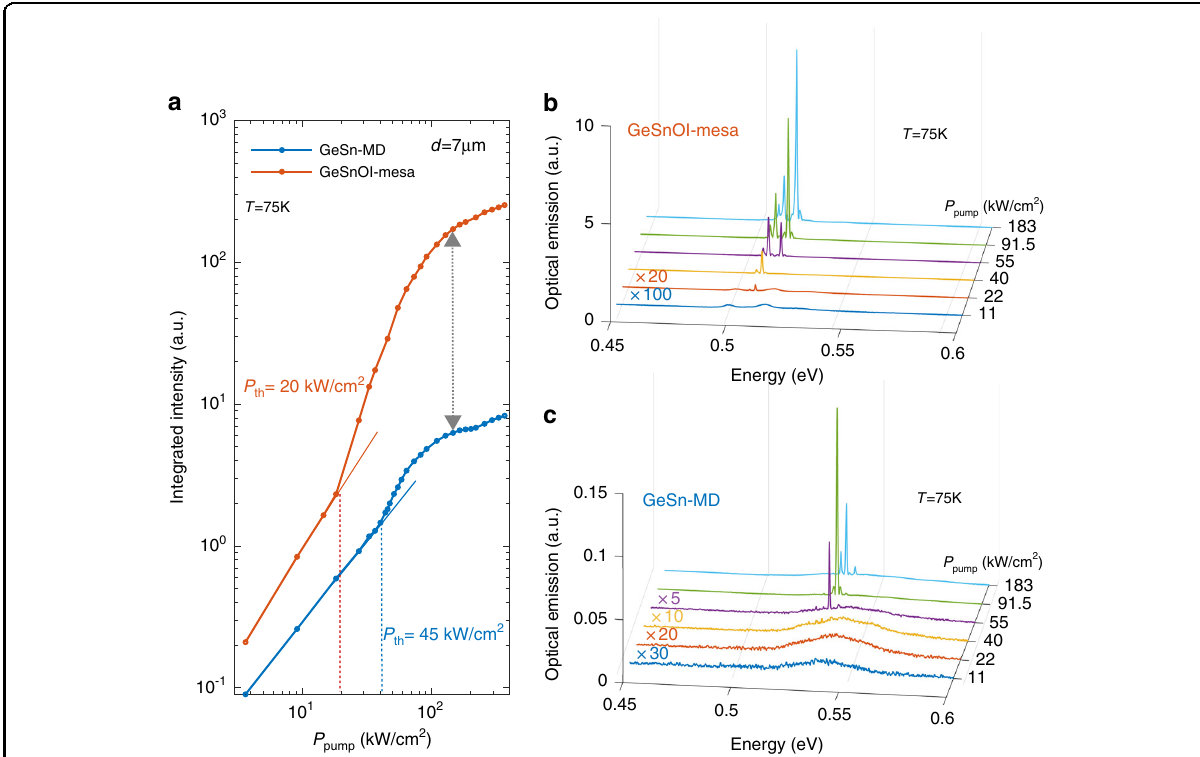
Fig. 3 GeSnOI mesa versus as-grown GeSn microdisk laser. a Light – Light (L – L) curves of 7 µm diameter GeSn microdisks and GeSnOI mesas with 360-nm-thick GeSn at 75 K under pulsed pumping ( b ) and c PL spectra at 75 K for various pulsed excitation powers for the GeSnOI mesa and the GeSn-MD, respectively. Excitation levels are given by the peak power